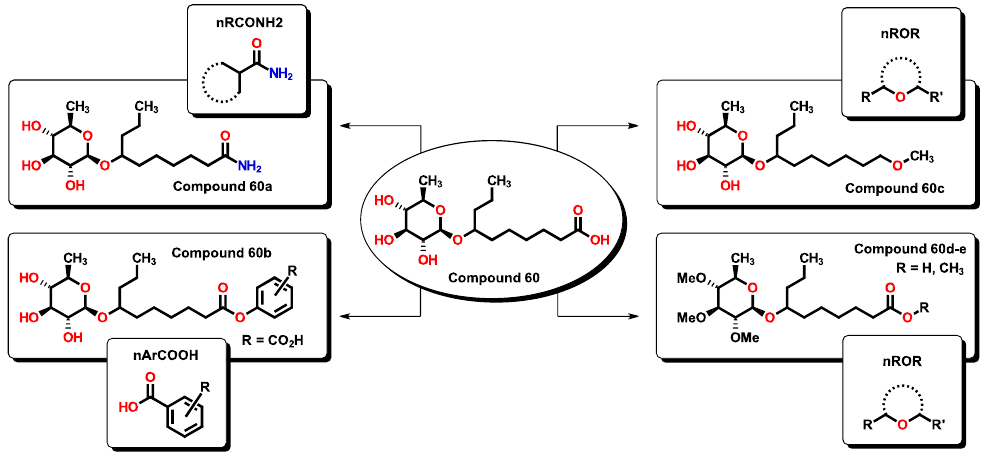
Figure 20. Proposed 60 -derivates which, in accordance with Equation (1), are expected to improve their antibacterial activity by incorporation of specific functional groups.